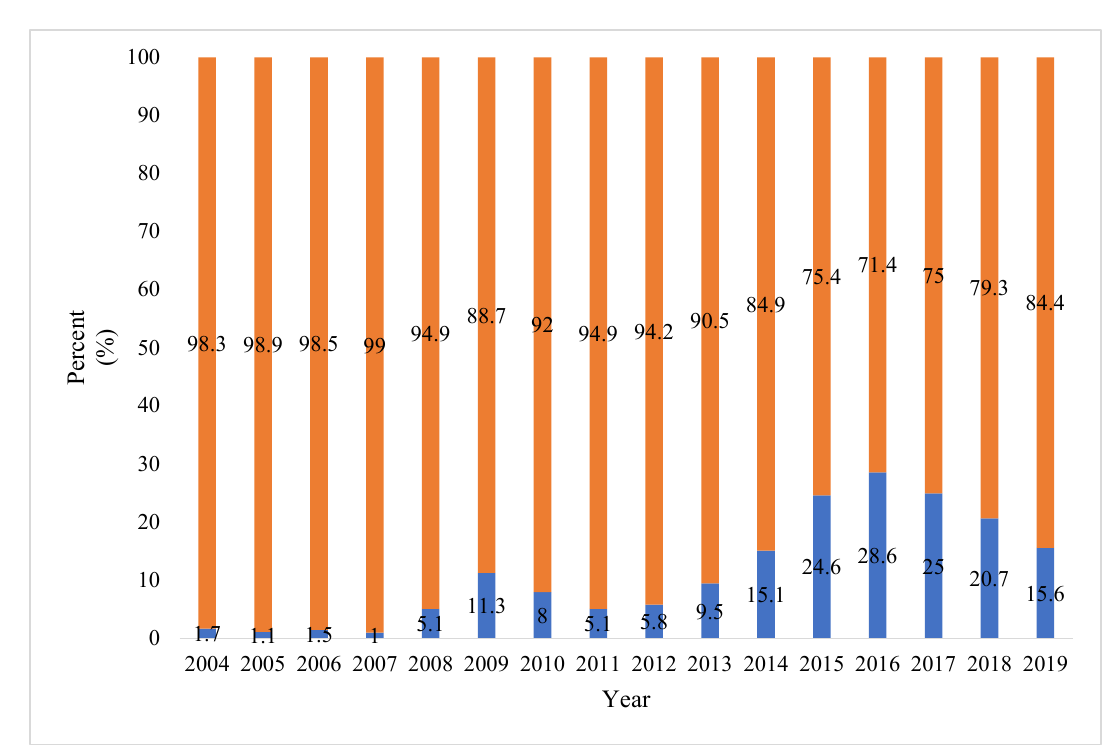
Figure 2. Share of profitable banks (orange color) without innovative mobile trading apps in 2004–2019 (%).